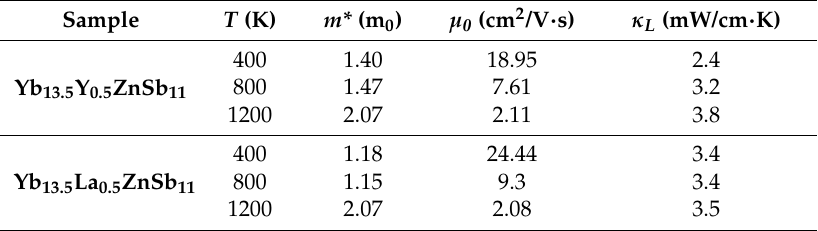
Figure 7. Pisarenko plots for the Yb 13.5 RE 0.5 ZnSb 11 (RE = Y, La) compounds calculated at 400, 800, and 1200 K.